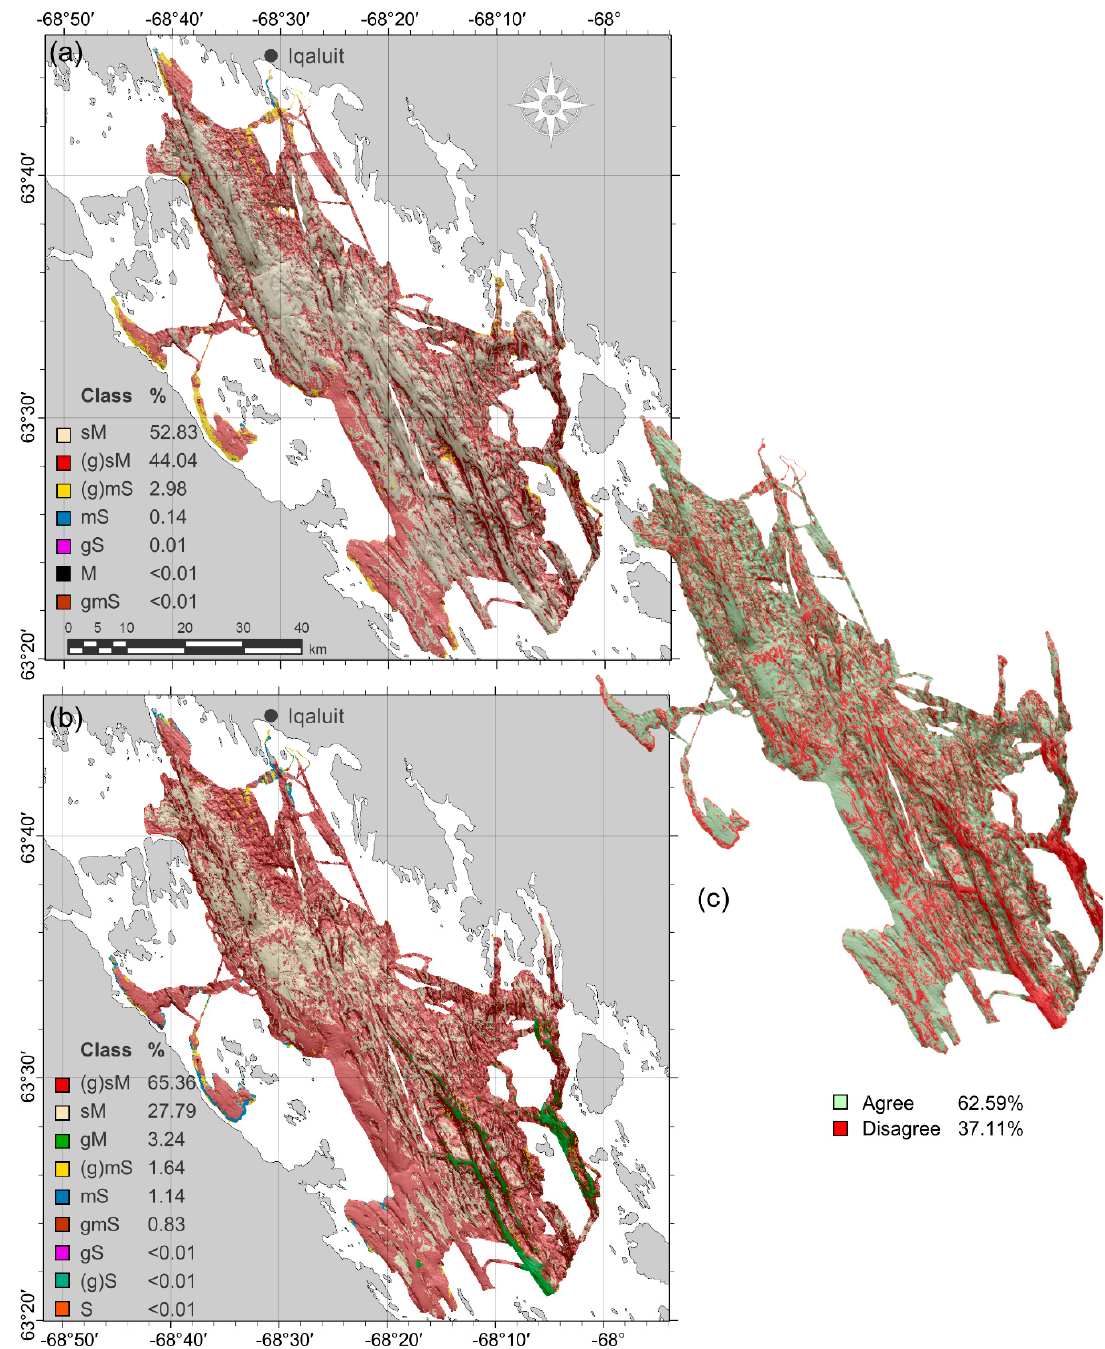
Figure 8. Predicted Folk grain size classes for ( a ) categorical and ( b ) quantitative models, with ( c ) agreement between predictions.